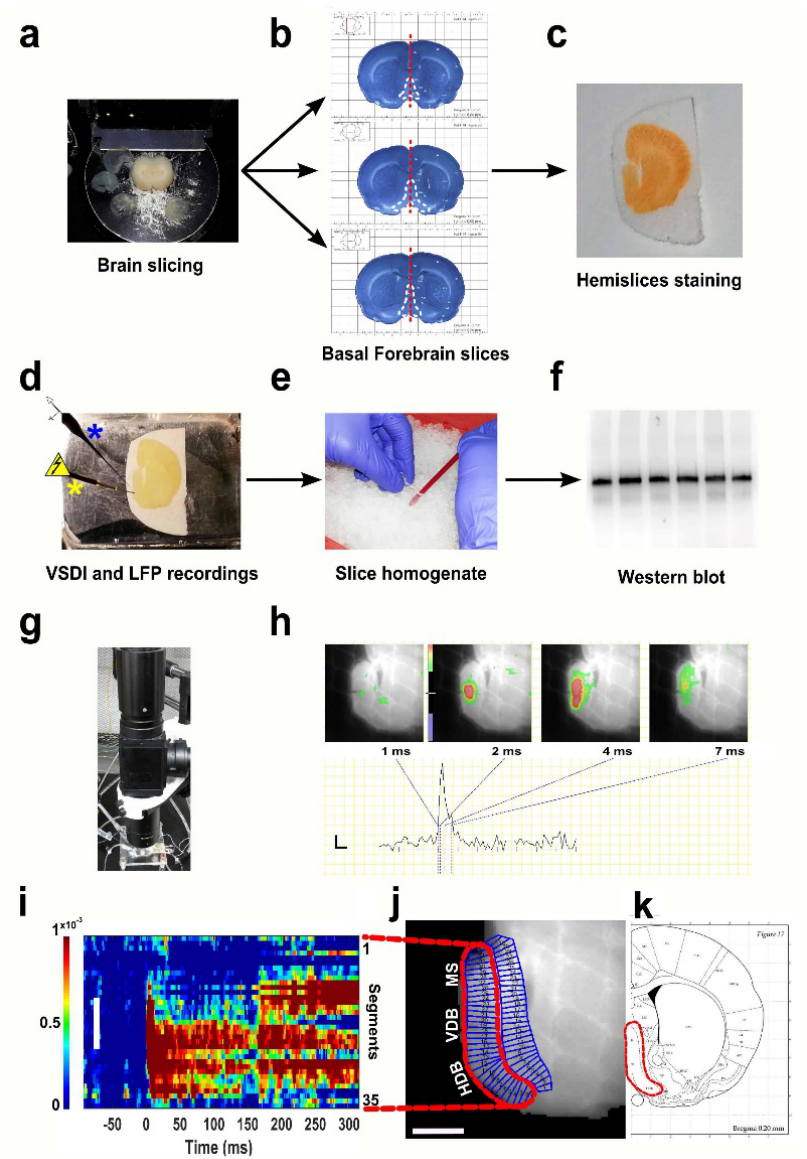
Figure 1. Schematic of the technical and experimental approach adopted in this study. Rat brains at four different ages (Postnatal Day 7 (P7), P14, P35 and P60) were sectioned ( a ) to obtain basal forebrain (BF)-containing slices [30] (white dashed lines) ( b ), which were subsequently cut along the midline (red dashed line in ( b )) and stained with the dye molecule ( c ). After recovery, hemislices were transferred in the recording chamber ( d ) and set up with a stimulating electrode (yellow asterisk) accompanied by a recording capillary for electrophysiology measurements (blue asterisk). After voltage-sensitive dye imaging (VSDI) experiments, brain tissue was homogenised ( e ) and successively used for WB analyses ( f ). The VSDI setup employed for optical recordings ( g ) and representative frames from a P7 hemisection ( h ) showing a colour-coded BF activation pattern after stimulus delivery (top) and corresponding trace (bottom) at different time points. ( i – k ) Overview of the region of interest (ROI) arrangement: selection of an area comprising the HDB (horizontal diagonal band), VDB (vertical diagonal band) and medial septum (MS) regions of the BF [26] ( j , k ), segmentation of the designated region ( j ) and rasterisation to obtain ‘space-time’ maps of activity ( i ). The scale bar in ( h ) is 5 ms on the x -axis and 0.025 ∆ F/F on the y -axis. The colour scale indicates depolarization (green to red). The white scale bar in ( i , j ) is 1 mm; colour bar units: ∆ F/F 0 . LFP: local field potential.